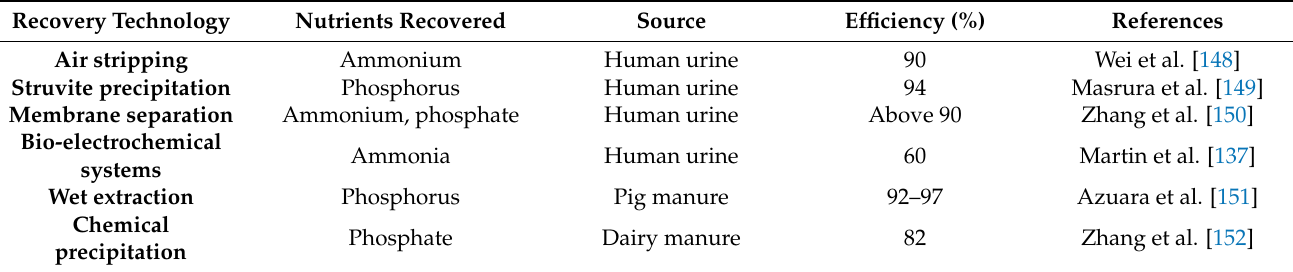
Table 8. Summary of nutrient recovery technologies from human and livestock